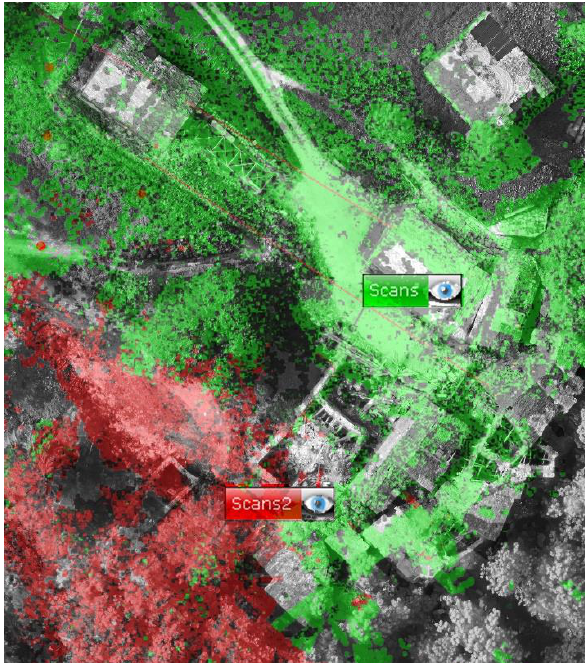
Figure 6. The two groups of scans covering the upper and the lower side of the